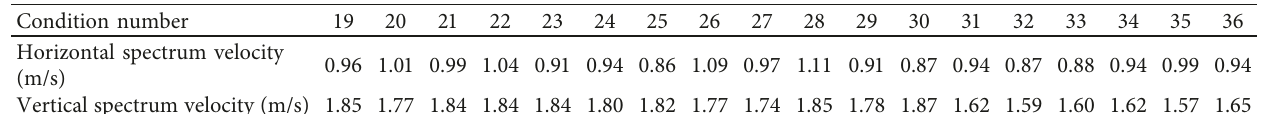
Table 7: Comparison of the structure’s average response on the port side.